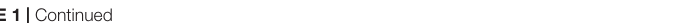
FIGURE 1 | Continued brain metastasis significantly more than hypoxia mediated angiogenesis. Bar graphs showing number of metastatic foci in stroke and hypoxic groups shown as mean ± SEM ( n = 6–8, four sections/animal, a p = 0.003, Mann–Whitney, two-tailed t -test). (H) Representative images from days 1 and 7 after stroke showing localization of fluorescent microspheres in green and vasculature (PECAM) in red. (I) Box and scatter plots with minimum and maximum percentage volume of fluorescent microspheres localized to the peri-infarct and contralateral regions at days 1 and 7 after stroke, mean ± SEM ( n = 5–6, one-way ANOVA, Holm-Sidak for multiple comparisons p = 0.46, ns, non-significant). (J) Schematics of the method of quantification of fluorescent microspheres volume localized around the peri-infarct regions. (K,L) Representative immunohistochemical images and intensity of endogenous albumin extravasated from days 1 and 7 after stroke and contralateral regions, mean ± SEM ( n = 5, three regions/animal, ∗ p = 0.0255, one-way ANOVA, Holm-Sidak for multiple